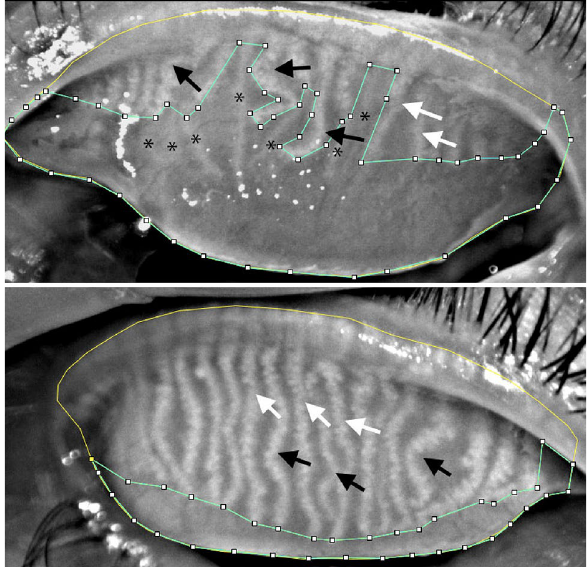
Figure 1. Image J assisted meibomian gland dropout evaluation in one patient (upper) and one subject from the control group (lower). The light green outlined regions represent the dropout area, while yellow outlined regions represent the tarsal plate. The MG loss was 59.9% and 15.3% in the patient and control subject, respectively. The glands with white arrows are examples of distorted glands, whereas the glands with black arrows are examples of tortuous glands. Glands marked with * represent ghost glands which are pale glands with absence of normal meibomian gland